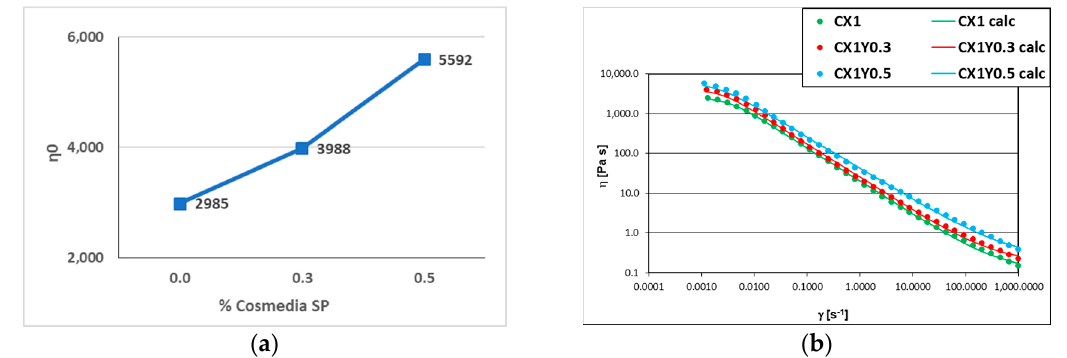
Figure 5. ( a ) Viscosity trends (experimental and fitted with Carreau-Yasuda model data) vs. shear rate ( b ) η 0 values of samples containing 1% of Bosexil ® added with different concentrations of polymer (0%, 0.3%, 0.5%).